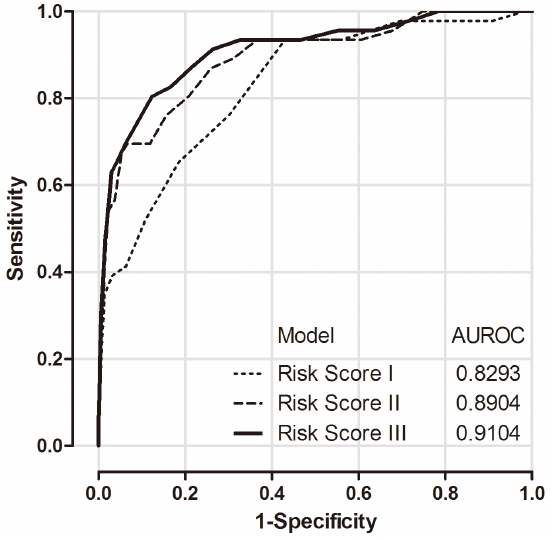
Figure 2. Receiver operating characteristic curves (ROCs) and areas under receiver operating characteristic curves (AUROCs). ROCs and AUROCs for the prediction of the 6-year incidence of hepatocellular carcinoma using sum scores of three risk models: The classical model (Risk Model I, dotted line), the model combining liver- related seromarkers without HBV seromarkers of HBeAg serostatus and serum HBV DNA level (Risk Model II, broken line), and the model combining liver-related seromarkers with HBV seromarkers (Risk Model III, solid line).